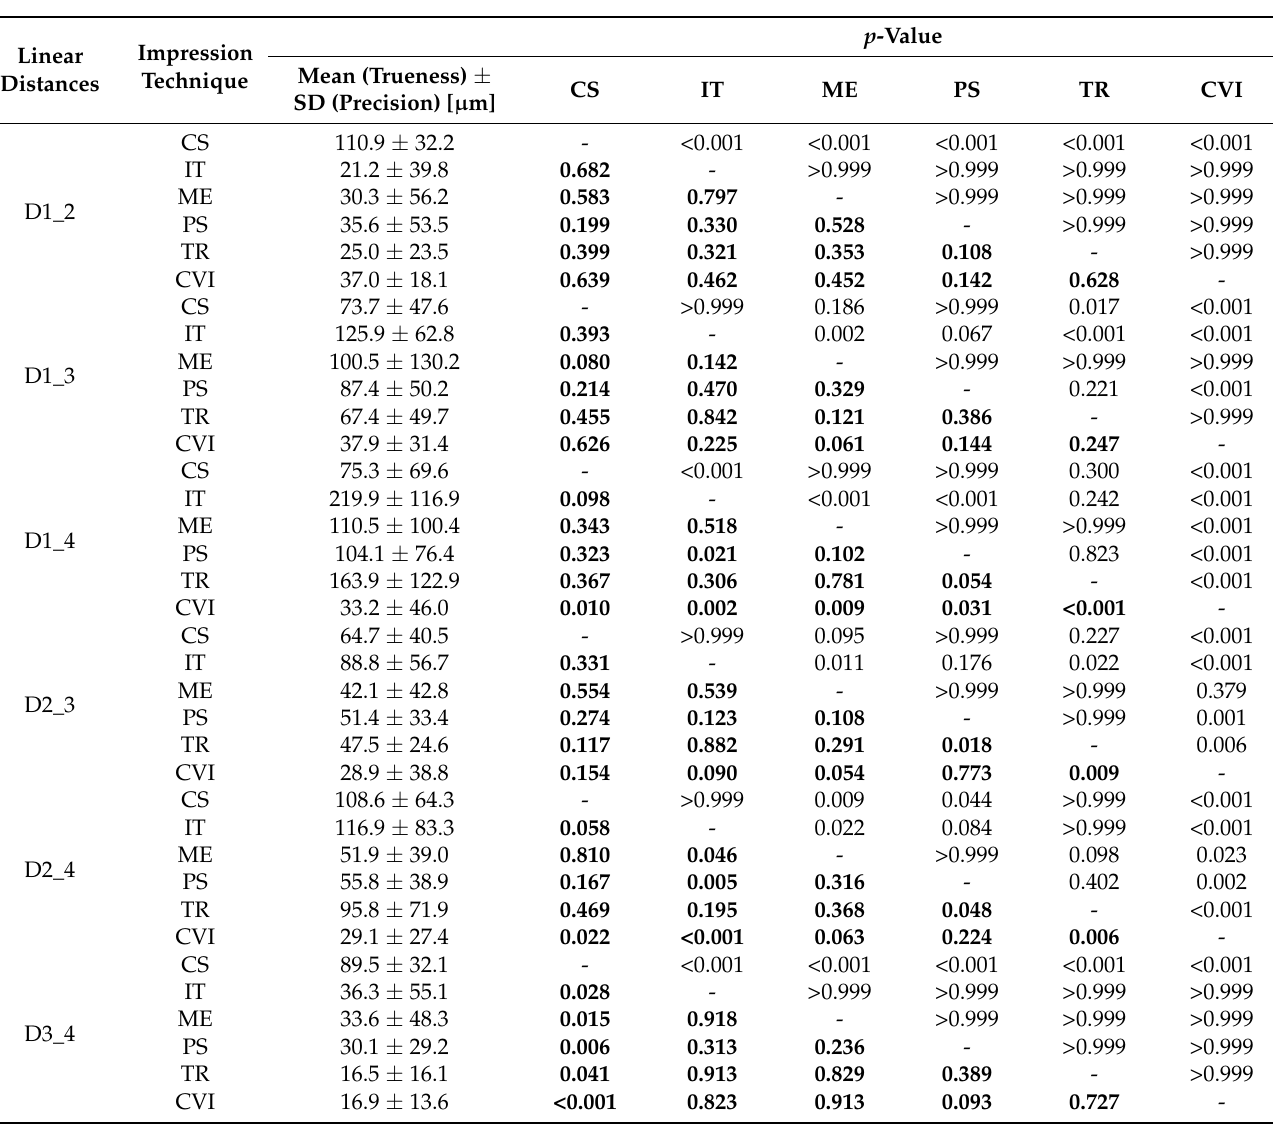
Table A1. Deviations (mean ± standard deviation (SD) [ µ m]) of the linear distances (D1_2, D1_3, D1_4, D2_3, D2_4, D3_4) of six impression techniques (CS = CS 3800, IT = iTero Element 5D, ME = Medit i700, PS = Primescan, TR = Trios 4, CVI = conventional impression) for Group A (young fully dentate) and statistical analysis for trueness (upper right part) and precision (lower left part, presented in bold type) according to ISO 5725